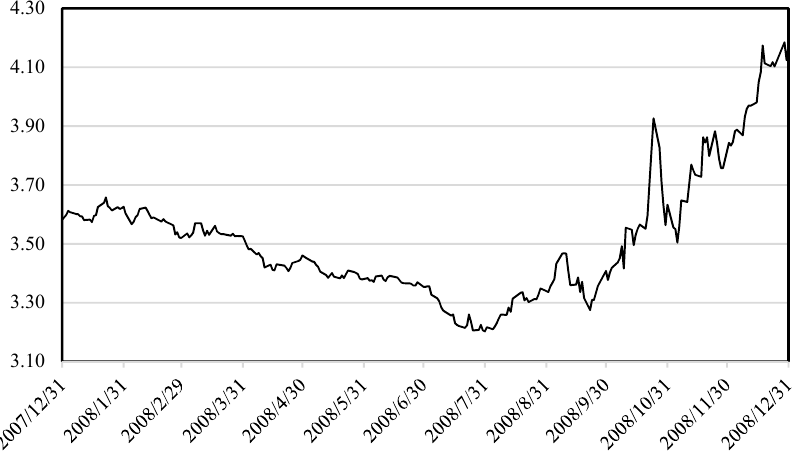
Figure 1. PLN/EUR exchange rates in 2008 according to the National Bank of Poland. Source: own study.